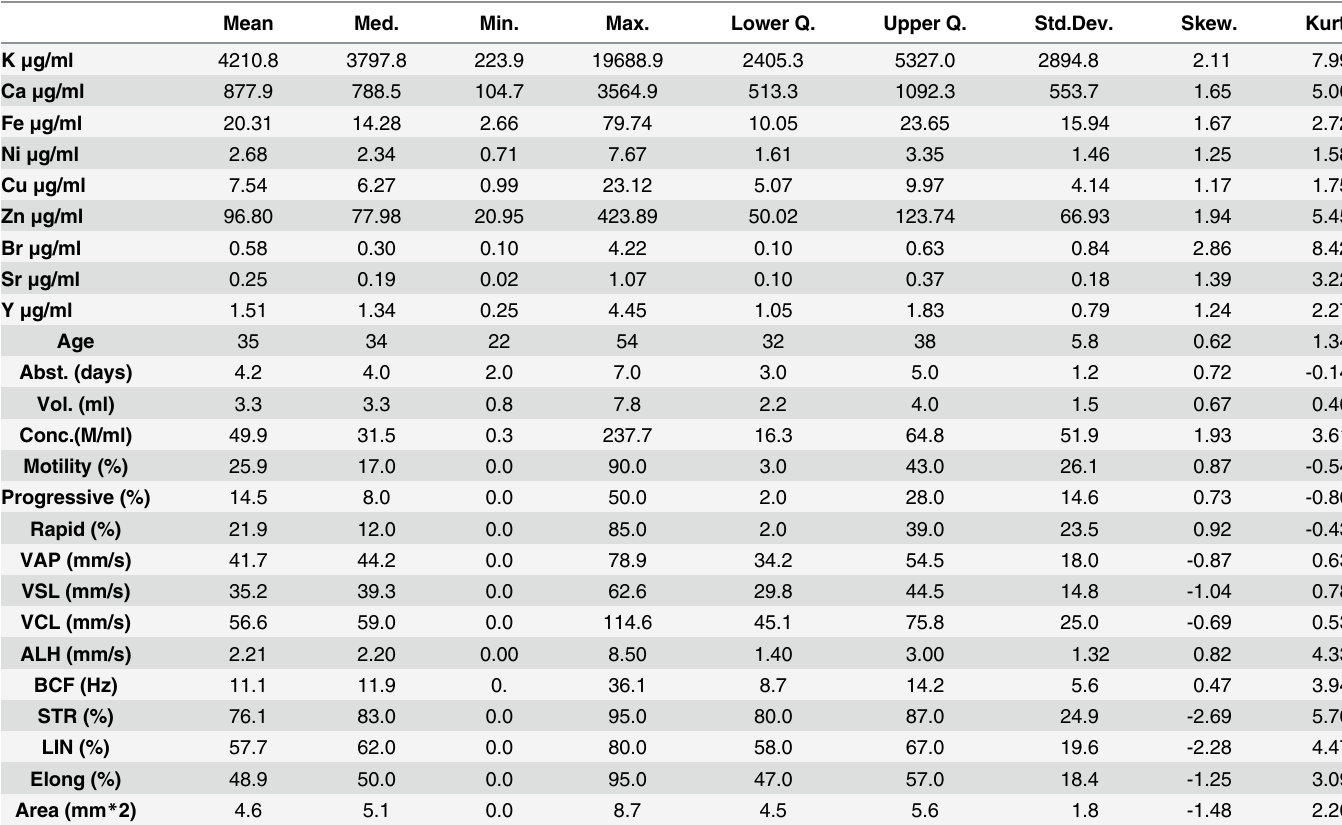
Table 1. Descriptive statistics for 97 semen